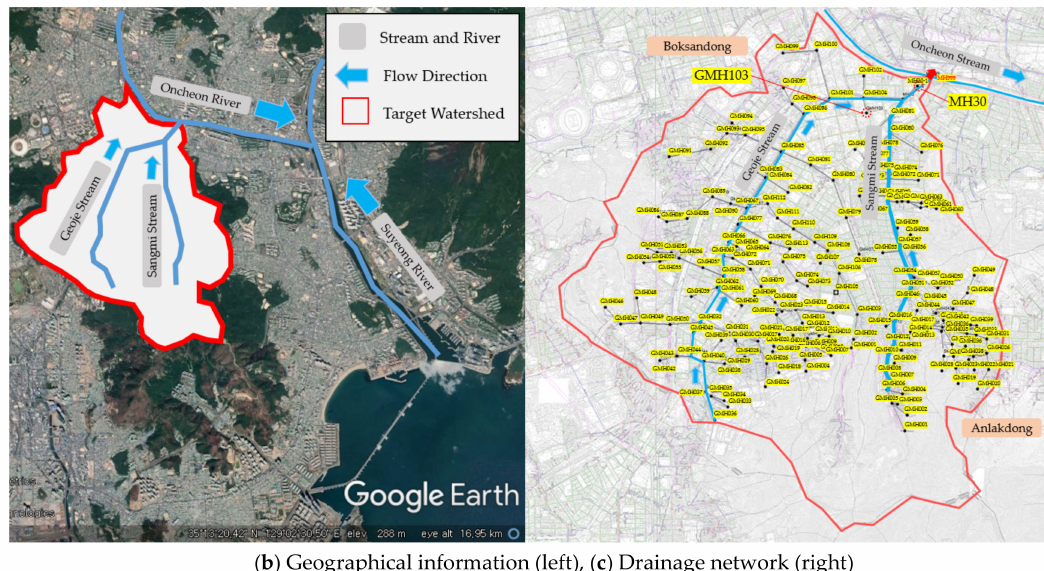
Figure 6. Geographical information and drainage network of Geoje